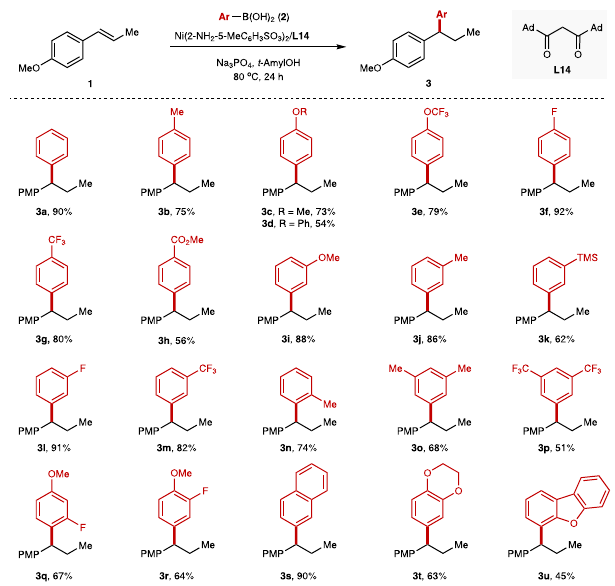
Fig. 3 | The scope of arylboronic acids. The values under each structure indicate isolated yields. The regioselectivity was determined by analysis of the crude 1 H NMR (rr>99/1 for all substrates). Reaction conditions: 1 (0.2mmol, 1.0 equiv), 2 (0.6mmol, 3.0 equiv), Ni(2-NH 2 − 5-MeC 6 H 3 SO 3 ) 2 (10mol%), L14 (10mol%), Na 3 PO